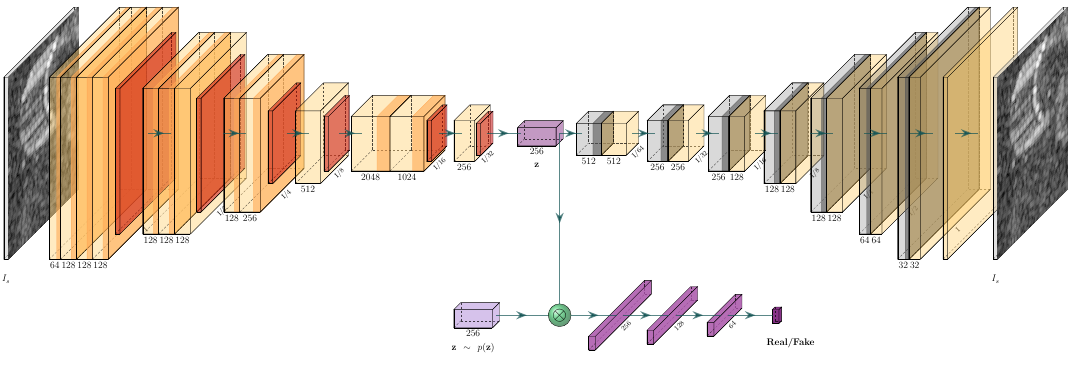
Figure 2: A single branch of the proposed network architecture. The autoencoder learns a meaningful latent code space z by learning to reconstruct the input image, while the discriminator network conditions the distribution of the latent codes using adversarial training and an arbitrary prior distribution. The optical branch is an exact mirror of the SAR branch and the discriminator network is shared between the